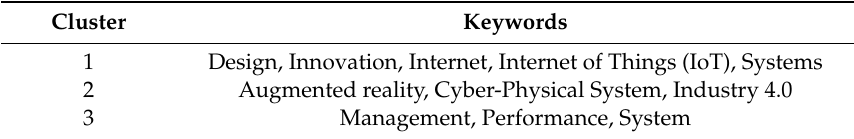
Table 4. Cluster of keywords that co-occurred together in Scopus under keyword search related to